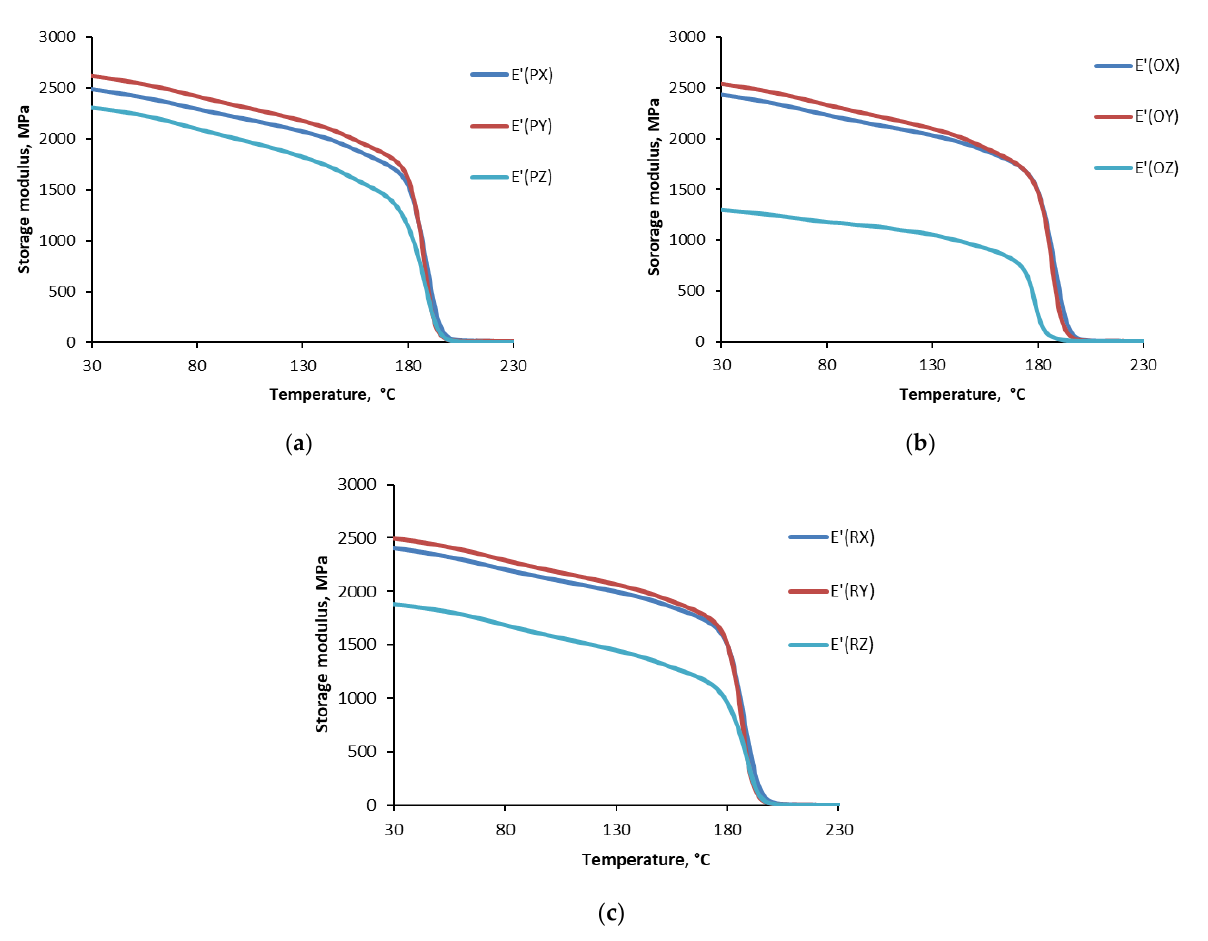
Figure 7. The storage modulus of ULTEM 9085 CG samples vs. temperature when cooled in the printer ( a ), oven ( b ), and at room temperature ( c ) and printed in X, Y, and Z directions.